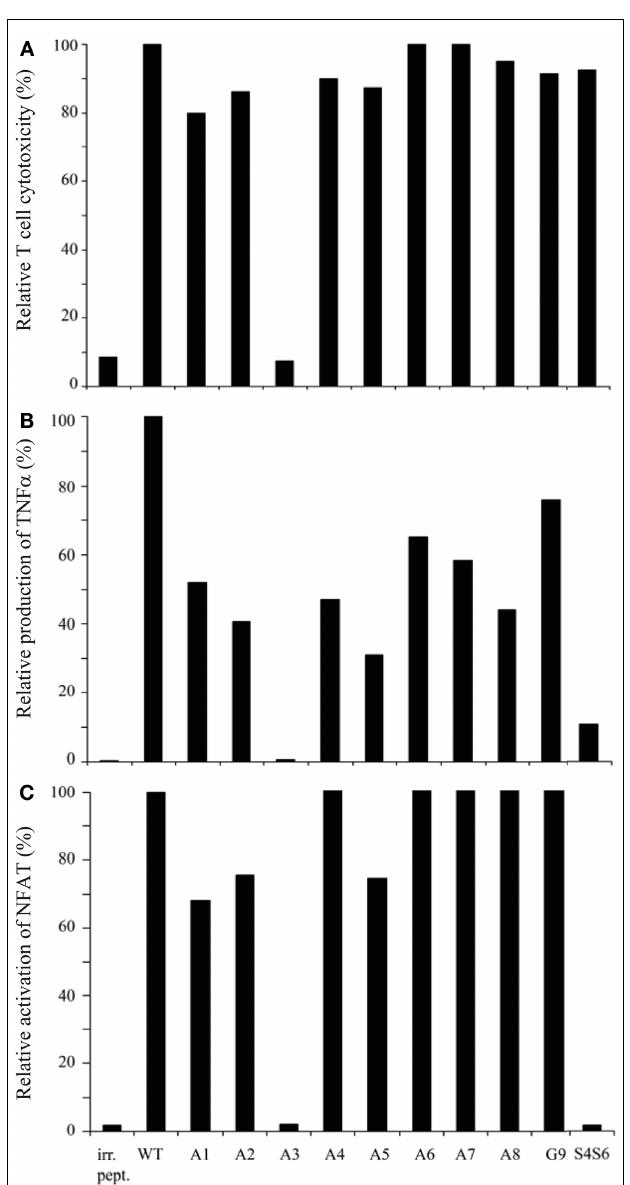
FIGURE 2 | gp100APLs with single amino acid substitutions function as full agonists except forAPLA3, which functions as a null ligand . HumanT cells transduced with gp100/HLA-A2TCR genes were tested in (A) 51 Cr-release, (B) TNF α production, and (C) NFAT reporter gene assays. Target cells used wereT2 cells that were pre-incubated with 1 µ M of gp100 wt peptide (wt), gp100 APLs A1–A8, and G9, or BMLF-1 wt peptide (irr. pept.). gp100 APLs are encoded as indicated in the Section “Materials and Methods.” In the 51 Cr-release,TNF α production, and NFAT reporter gene